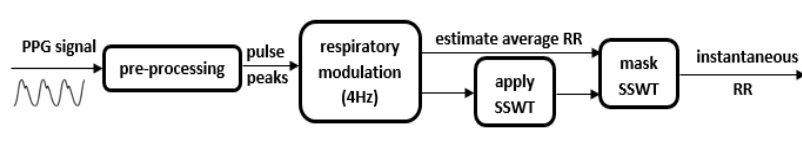
Figure 3. Diagram of the proposed algorithm to estimate IRR from wristworn PPG. The pre-processing stage includes the SSA algorithm which helps to better detect pulse peaks. Masking the time-frequency spectrum given by the WSST transform is crucial in identifying the appropriate band of respiratory frequencies, which will vary from patient to patient, and for changing health status of the individual